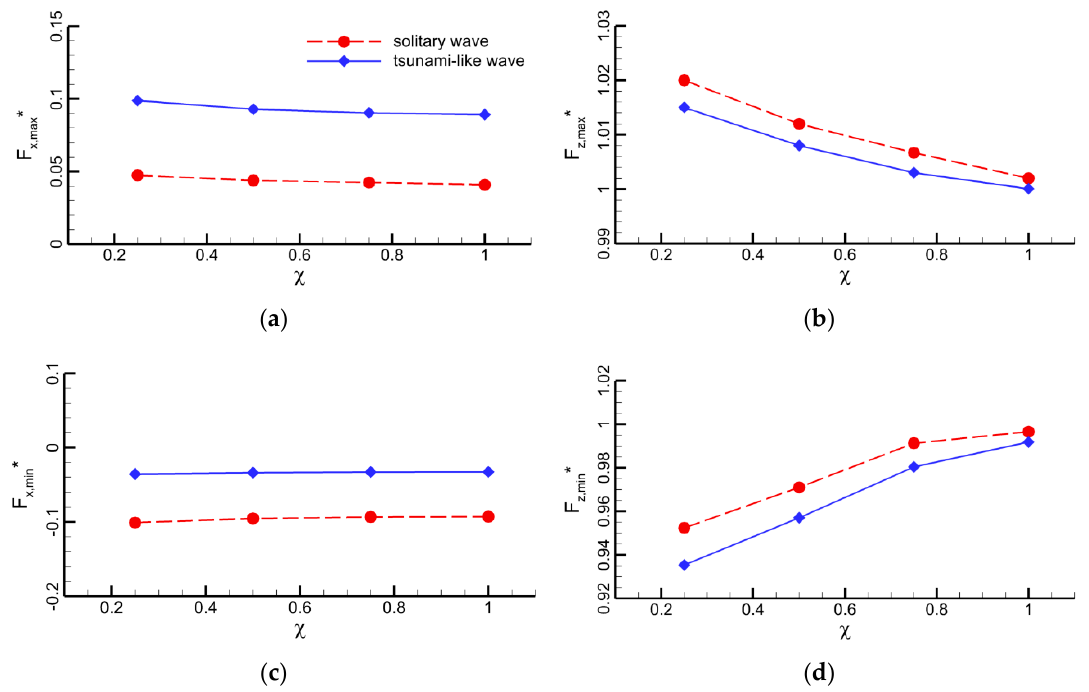
Figure 27. Plots of the maximum horizontal and vertical forces as a function of gap-ratio; ( a ) maximum horizontal force F x,max *; ( b ) maximum vertical force F z,max *; ( c ) minimum horizontal force F x,min *; ( d ) minimum vertical force F z,min *.